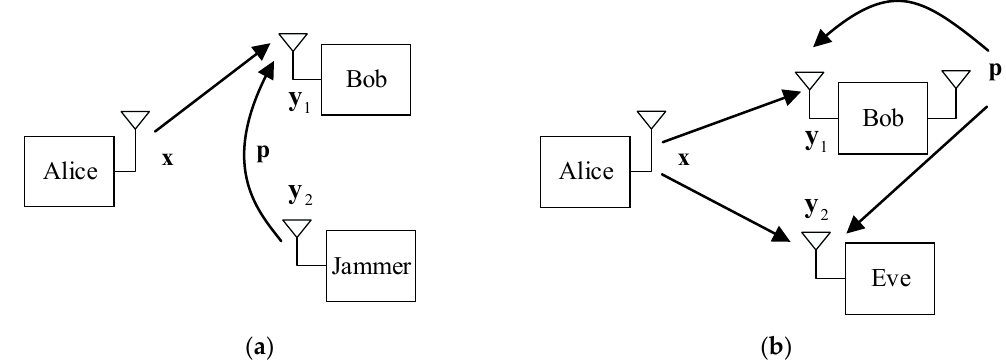
Figure 1. System model. ( a ) Active jamming, where the jammer transmits adversarial perturbation signal. ( b ) Passive eavesdropping, where the full-duplex (FD) Bob transmits adversarial perturbation signal.